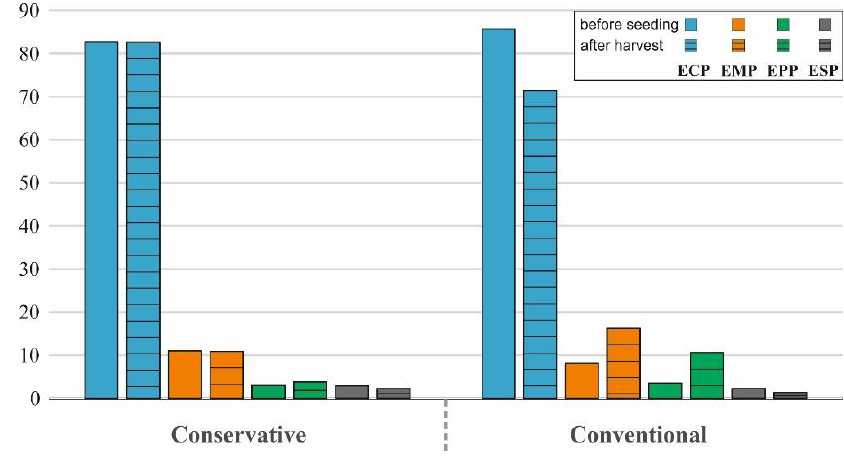
Figure 9. ECP, EMP, EPP, and ESP mean values of conservative and conventional soils in the first (before seeding) and second (after harvest) sampling.